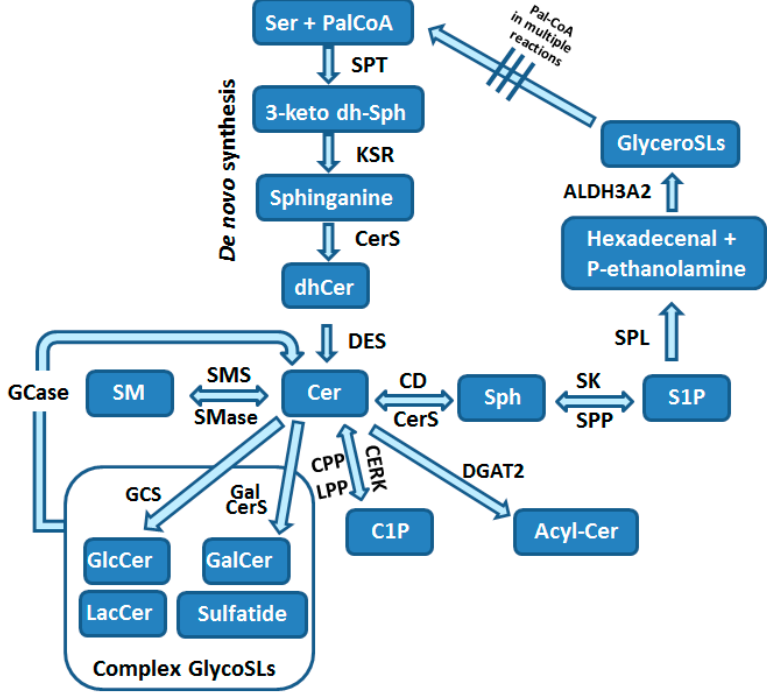
Figure 2. Transcriptomic data from islets and qRT-PCR results from beta-cell lines suggest that beta-cells express all genes regulating the SL pathway. The exact mRNA and protein expression level of various enzymatic components of the SL pathway in human beta-cells still needs to be characterized. Enzymes: ALDH2A3, fatty aldehyde desaturase A3, CD, ceramidase, CERK, ceramide kinase, CPP, ceramide 1-phosphate phosphatase, CerS, ceramide synthase, Des, sphingolipid-delta-4-desaturase, DGAT2, diacylglycerol acyltrasferase-2, GCS, GlcCer synthase, GalCerS, GalCer synthase, GCase, glycosidase, KSR, 3-keto sphingosine reductase, LPP, lysophospholipid phosphatase, SMS, sphingomyelin synthase; SMase, sphingomyelinase, SK, sphingosine kinase, SPP, sphingosine 1-phosphate phosphatase, SPT, serine palmitoyltransferase,